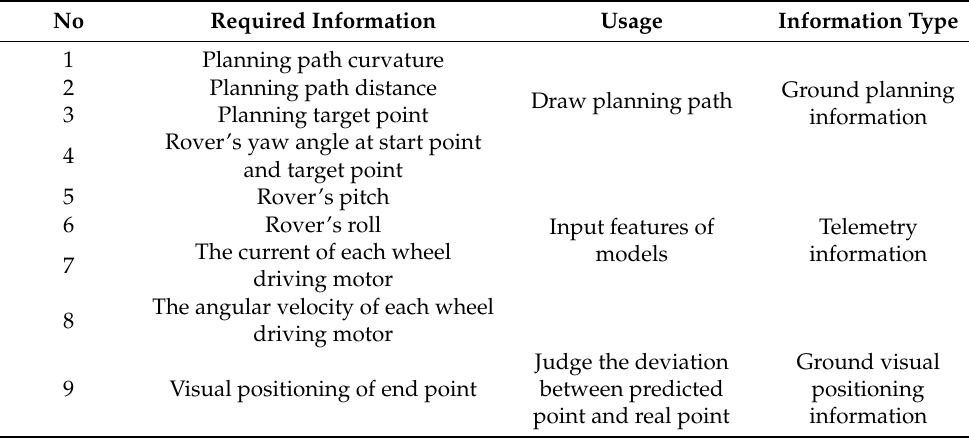
Table 5. Planning end points and actual end points of arrival.